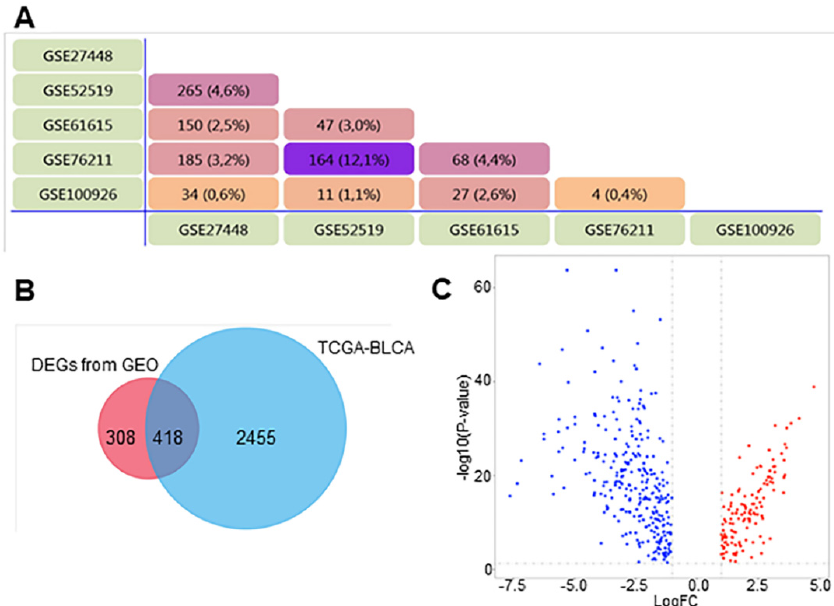
Figure 2. Venn diagram and Volcano plot of DEGs. ( A ) DEGs were selected with | log Fold Change (FC) | > 1 and p -value < 0.05 among the mRNA expression profiling sets GSE27448, GSE525519, GSE61615, GSE76217andGSE100926. ( B )Overlappedthe726DEGswithTCGA-BLCAdatabase. ( C )132upregulated genes and 286 significantly downregulated genes in BCa samples. Upregulated genes are marked in red; downregulated genes are marked in